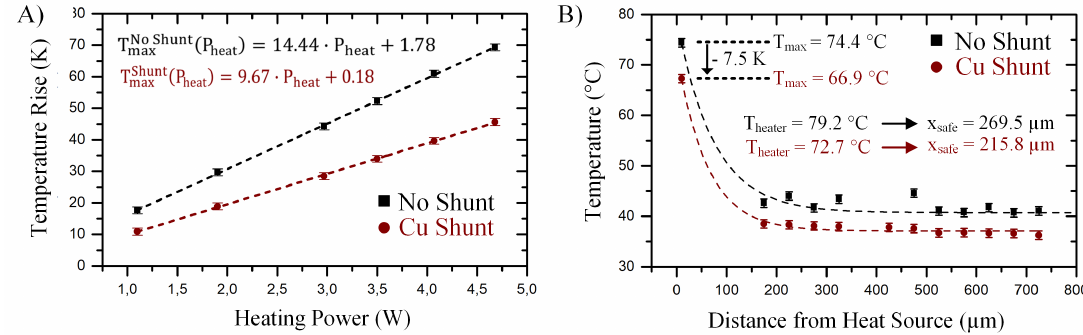
Figure 8. ( A ) Comparison of the heater temperature rise for different heating powers between a demonstrator without and with Cu-shunts. ( B ) Comparison of the temperature profiles measured in a thermal demonstrator with an 100 µ m wide and 330 µ m deep trench, without (black) and with (red) a 2.5 µ m thick Cu-shunt. Both measurements were performed using 3.71 W heating